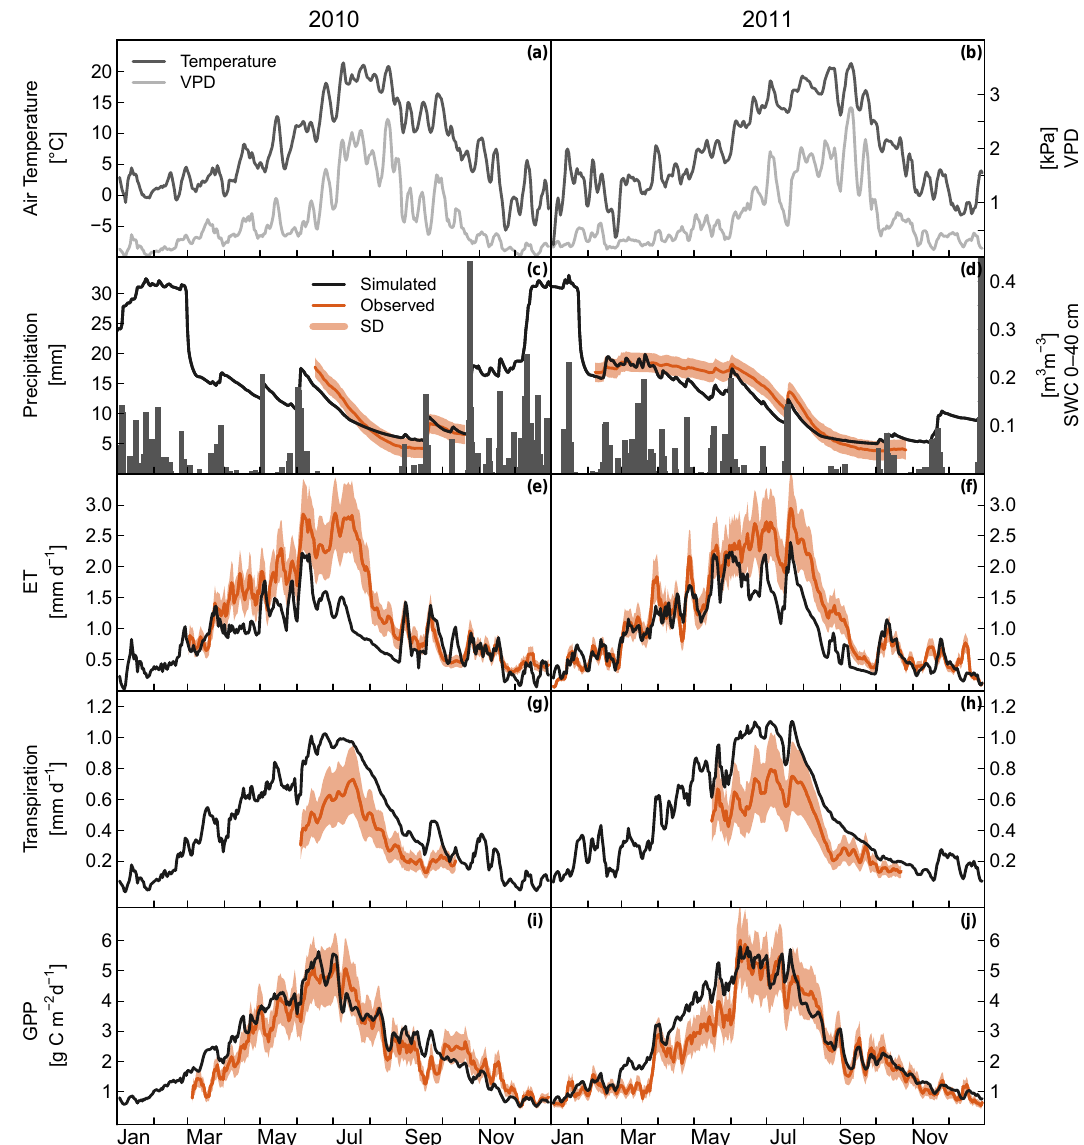
Figure 1. Seasonality of daily meteorological conditions (a–d) and observed and simulated evapotranspiration (ET, e and f ), transpiration ( g and h ) and gross primary productivity (GPP, i and j ) during 2010 and 2011. Bars are sums of daily precipitation, and observed and simulated soil water content (SWC) are daily averages. Simulated wintertime SWC above field capacity ( > 0.23m 3 m − 3 ) results from surface layer freezing. Air temperature, daytime vapor pressure deficit (VPD) and flux data are 5 day moving averages. Error estimates (SD) for observational data are given by the lighter colored areas around the mean. Note that observed transpiration fluxes do not include understory